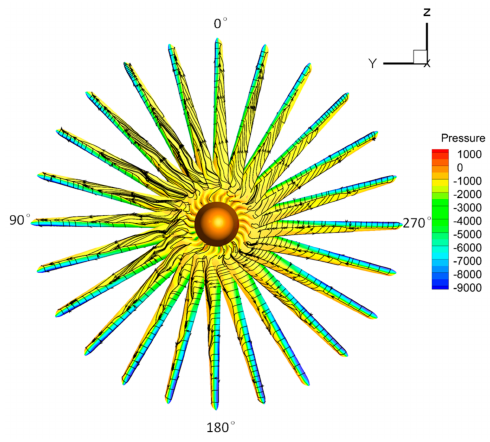
Figure 12. Contour of pressure distribution and streamlines of wall shear stress on the blade surface with inflow of 24 m/s, TSR = 4.2, at the yaw angle of 30 ◦ .